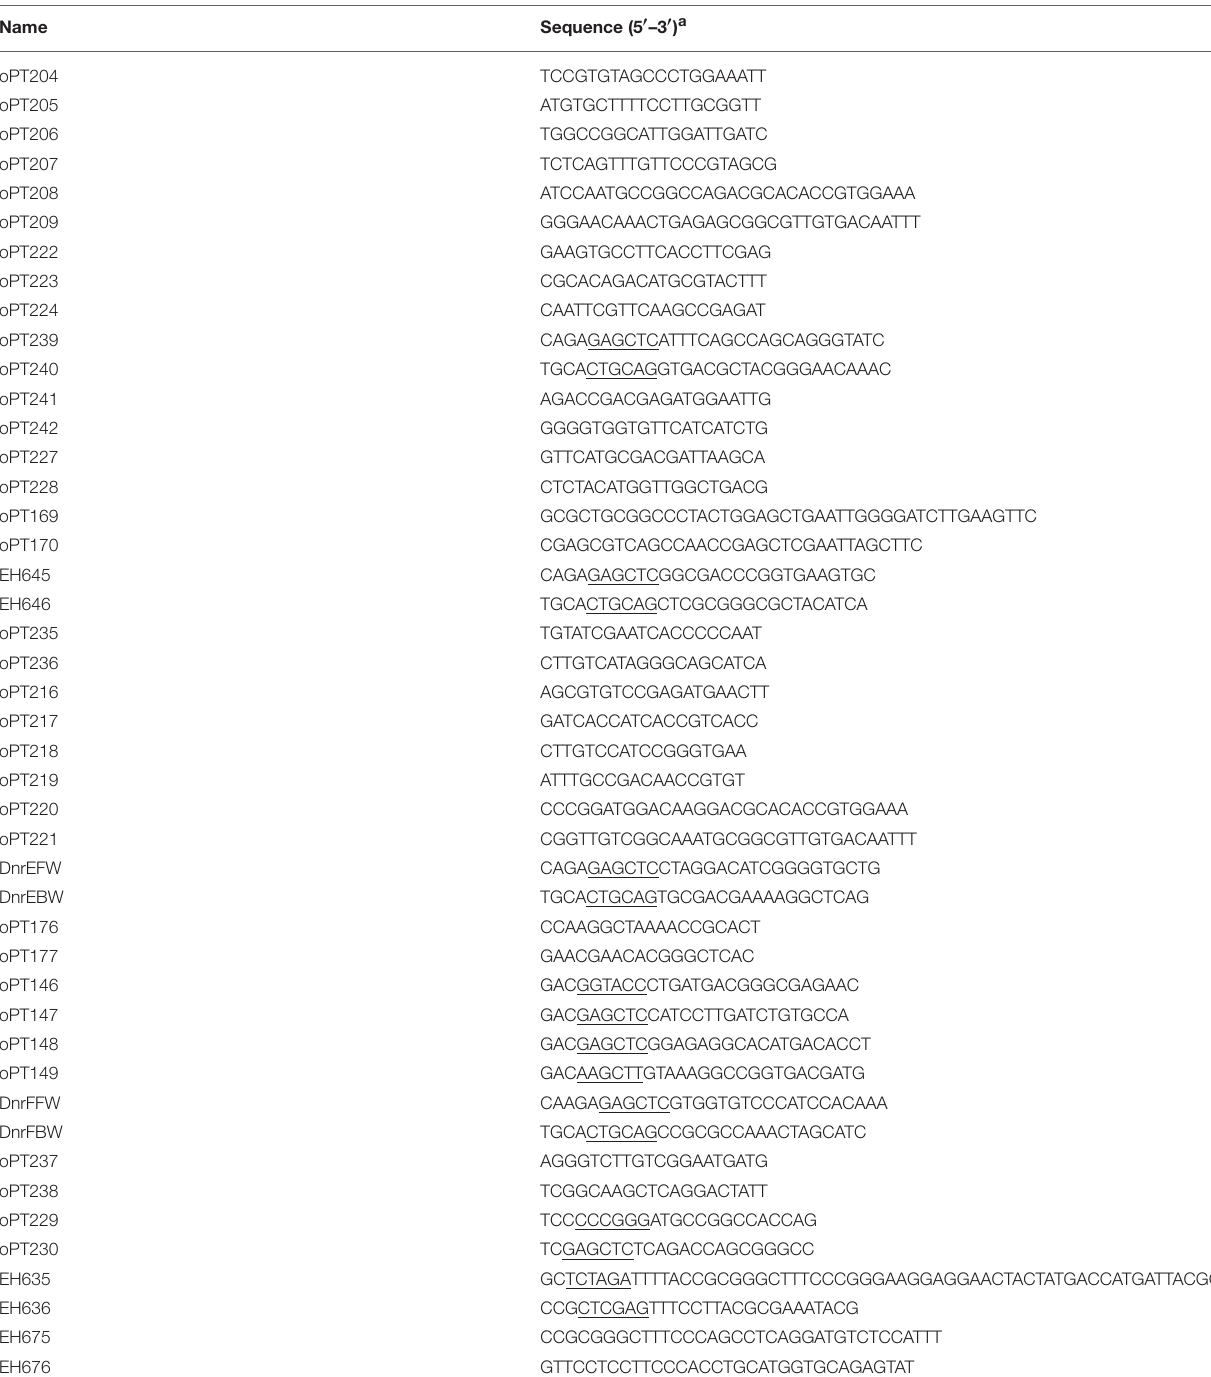
TABLE 2 | Primers used in this